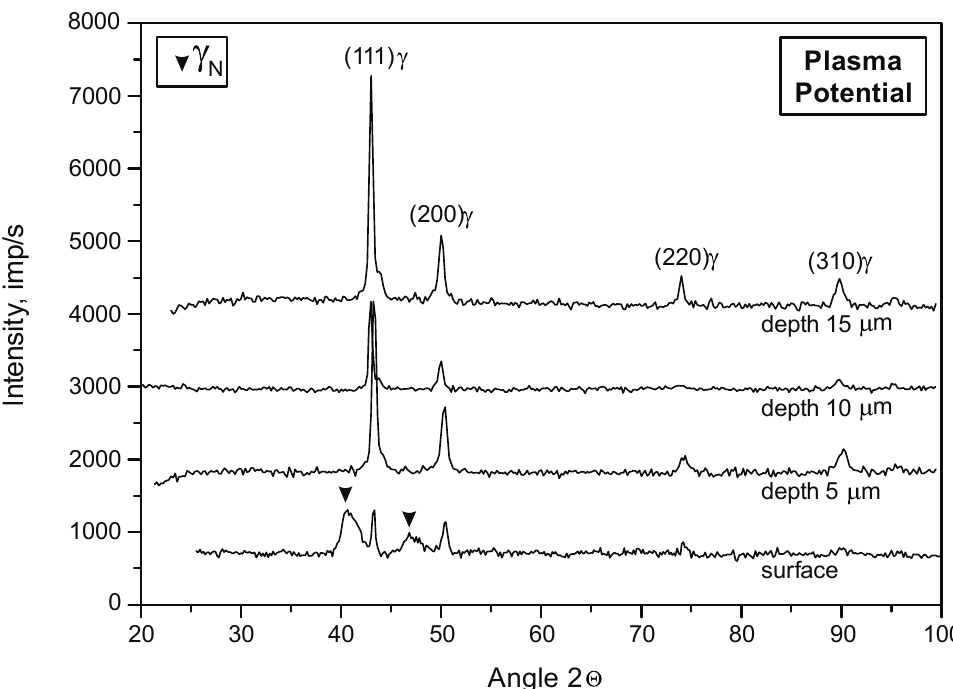
Figure 3. Diffractograms of the nitrided layer on the substrate of 316L steel depending on the depth in the cross-section of the surface layer. Nitriding in plasma potential, T = 490 °C, t = 8 h.